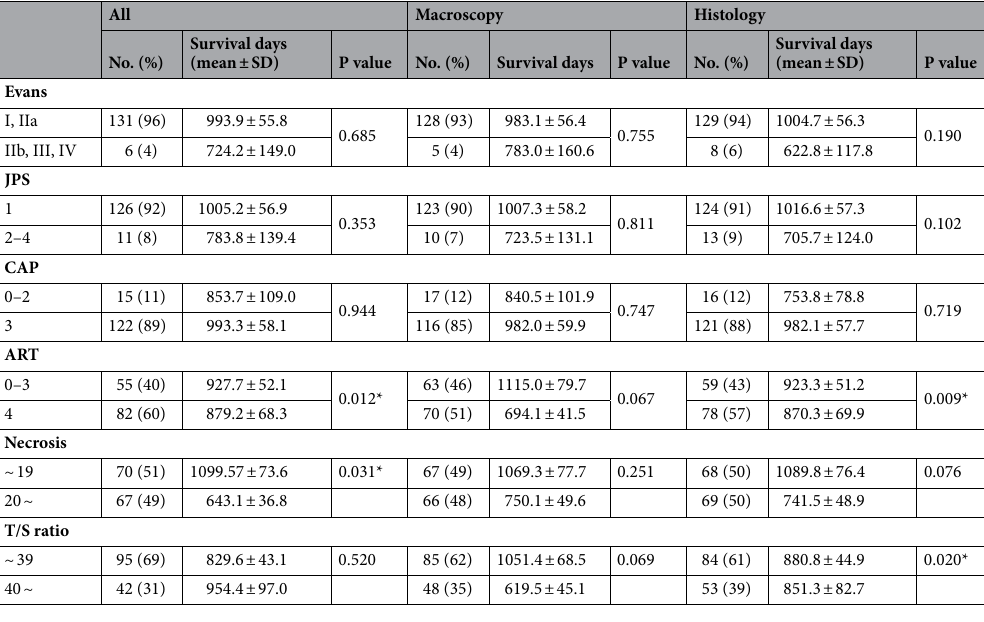
Table 3. P value of the log-rank test for overall survival after surgery. *P < 0.05 by log-rank test. There were no cancer cells in the slides of macroscopic defined largest tumor of 4 patients; thus, we did not assess tumor regression grades of